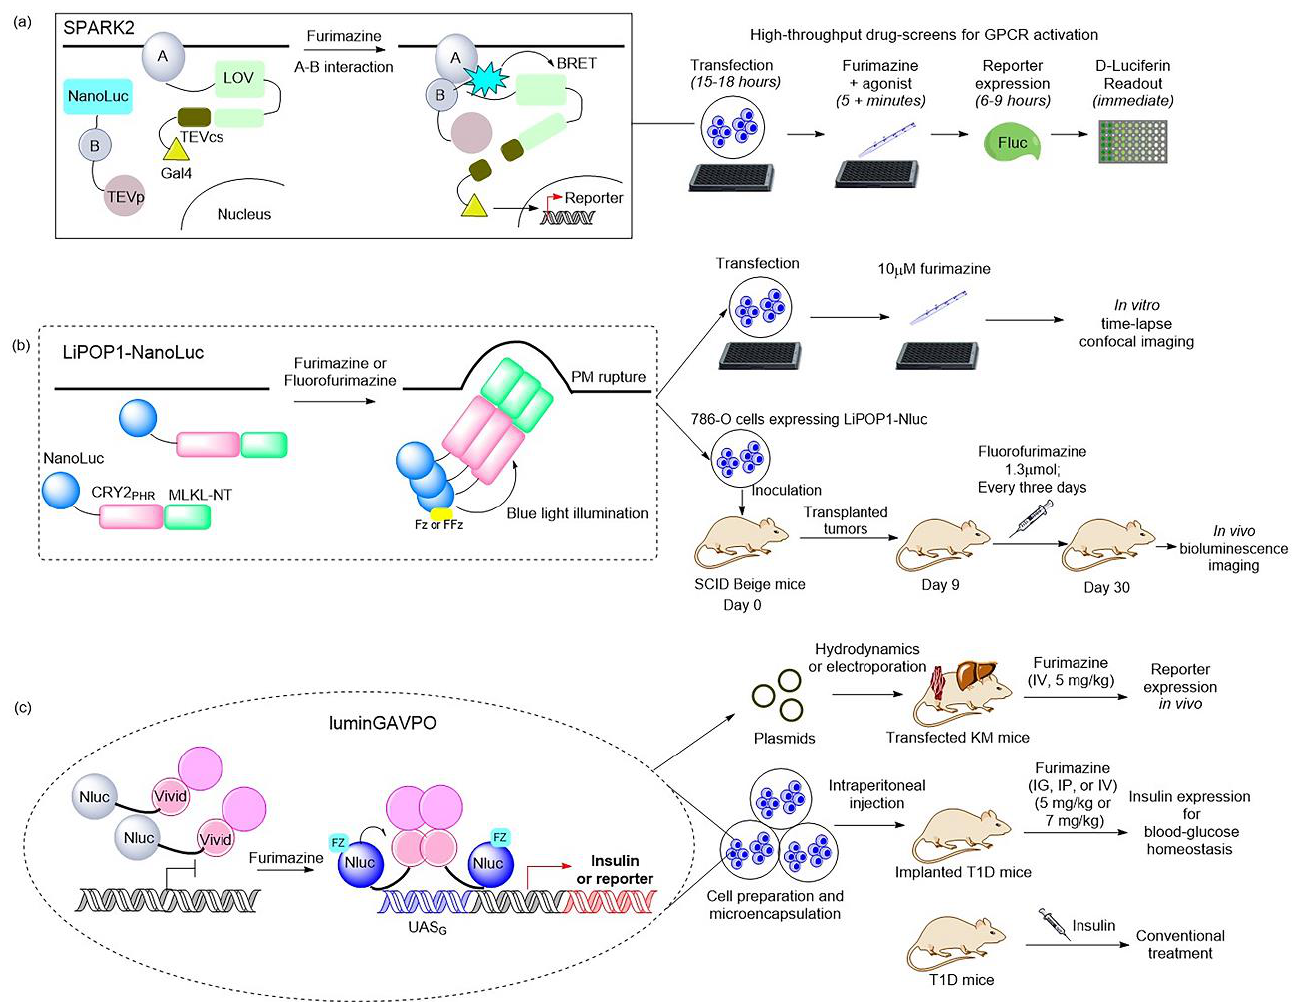
Figure 3. Illustrations of classic BRET-based photosensory probes. ( a ) Schematic of SPARK2 and its general flow for high-throughput GPCR agonist screening [19,84]. SPARK2 contains two modules: One is the fusion of target protein A, an LOV domain, and a transcription factor with a peptide linker including the TEVcs domain. The other is the fusion of target protein B, NanoLuc, and the TEV protease. When the target proteins are close enough to interact and the luciferin is provided, the BRET activates the LOV domain to expose TEVcs for protease cleavage in order to induce the release of transcription factors. ( b ) Schematic of LiPOP1 and its experimental procedure for controlling nonapoptotic cell death in vitro and in vivo [22]. LiPOP1 – NanoLuc was generated by inserting NanoLuc into LiPOP1 between mCherry and CRY2. With the addition of the FFz, the blue bioluminescence catalyzed by NanoLuc stimulates CRY2 to undergo oligomerization, which causes MLKL to expose the N-terminal helix bundle domain and destroy the membrane. ( c ) Schematic of luminGAVPO and its application for pulsatile activation of transgene expression in mice [23]. luminGAVPO is the fusion of NanoLuc and a light-switchable transcription factor GAVPO. Light stemmed from the NanoLuc – furimazine reaction activates the VVD domain in the transactivator in order to cause dimerization and binding of luminGAVPO to the related promoter, thus leading to downstream gene transcription.